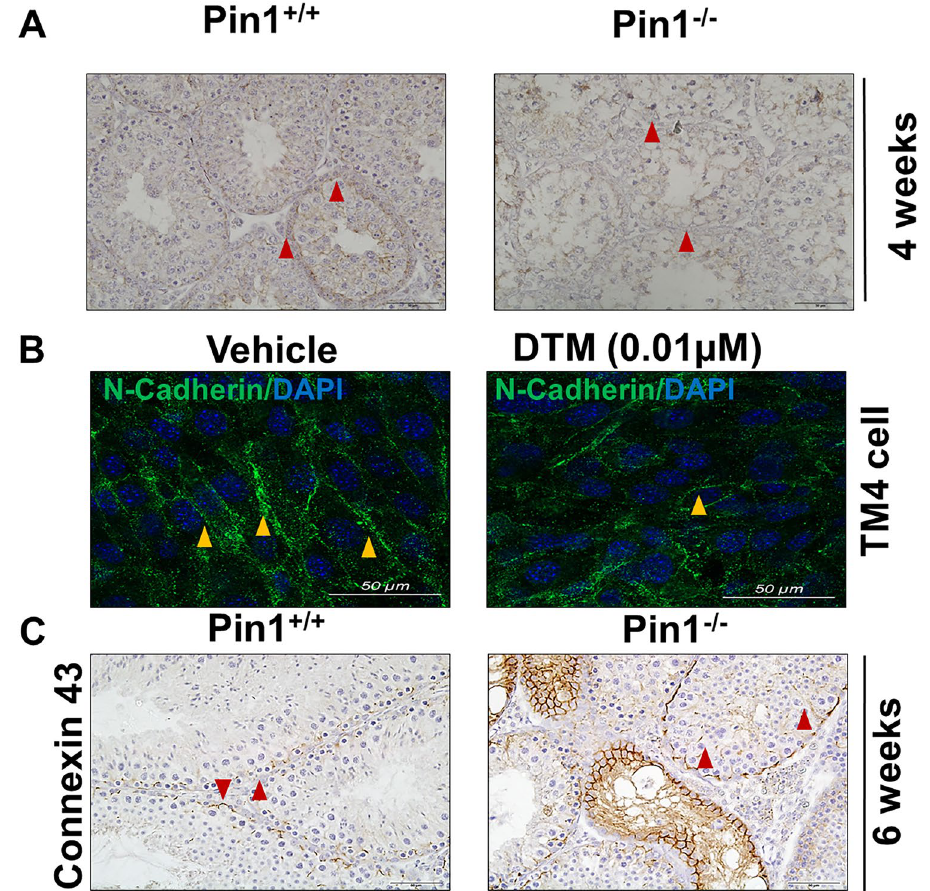
Figure 6. N-cadherin expression is decreased in Pin − / − testes and is unorganized in TM4 cells after Pin1 inhibition. ( A ) Testicular tissue sections from 4-week-old mice were immunostained for N cadherin expression (scale bar = 50 µ M). ( B ) Confocal microscopy images of TM4 cells with endogenous Pin1 catalytic function inhibited by DTM (0.01 µ M) a known inhibitor for Pin1 activity. Cells were stained for N-cadherin (Alexa-488/ green) and counterstaining with DAPI (scale bar = 50 µ M). ( C ) The BTB junction protein Connexin 43 was immunostained in testicular tissue of 6-week-old Pin1 + / + and Pin1 − / − mice (scale bar = 50 µ